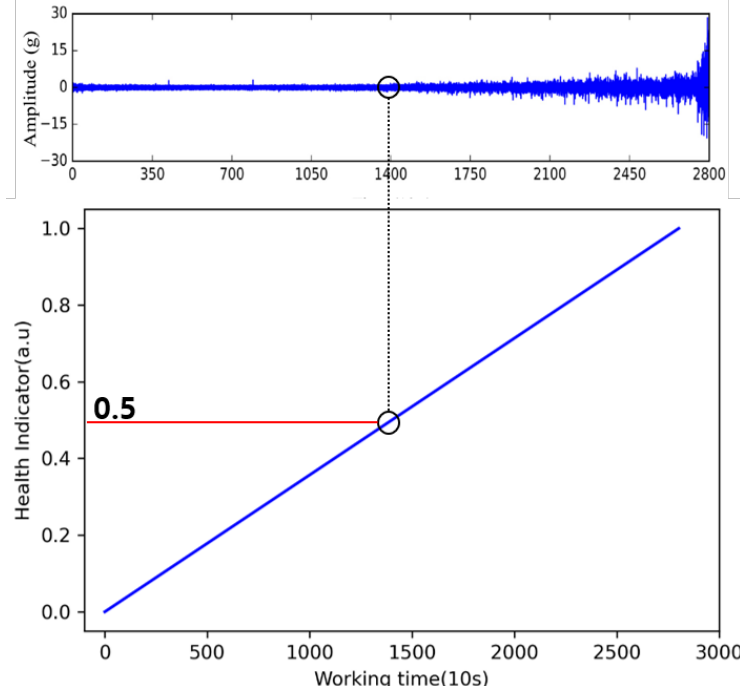
Figure 8. Definition of health